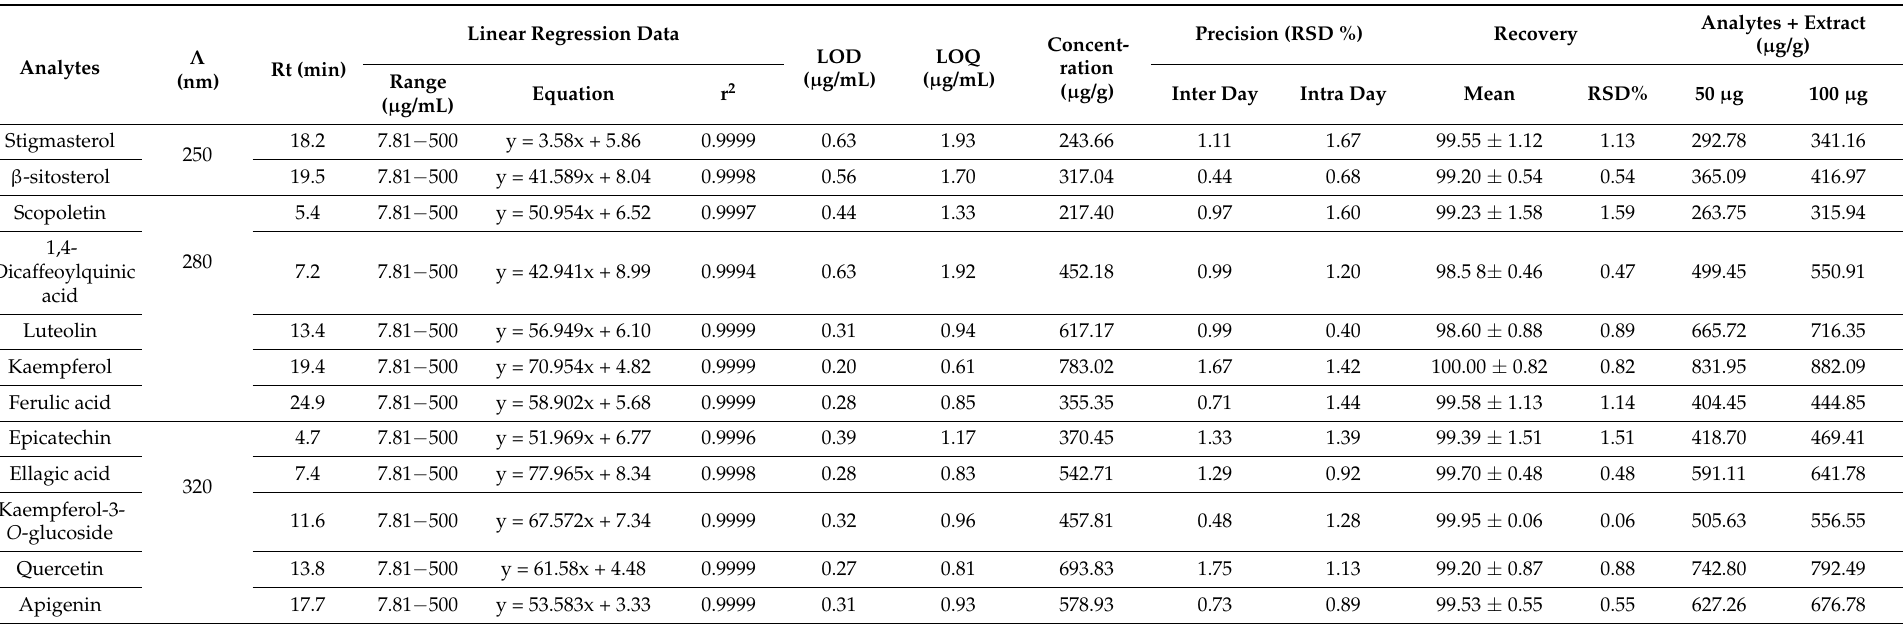
Table 2. Quantification and method validation of bioactive compounds of a hydroethanolic extract of Cucumis sativus L.